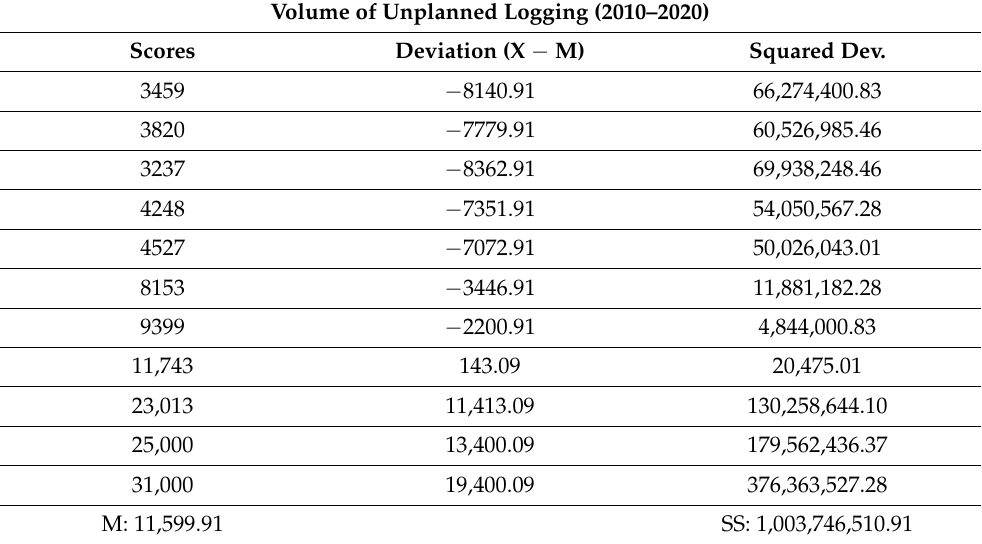
Table 2. Standard Deviation and Variance—Volume of the unplanned salvage logging.